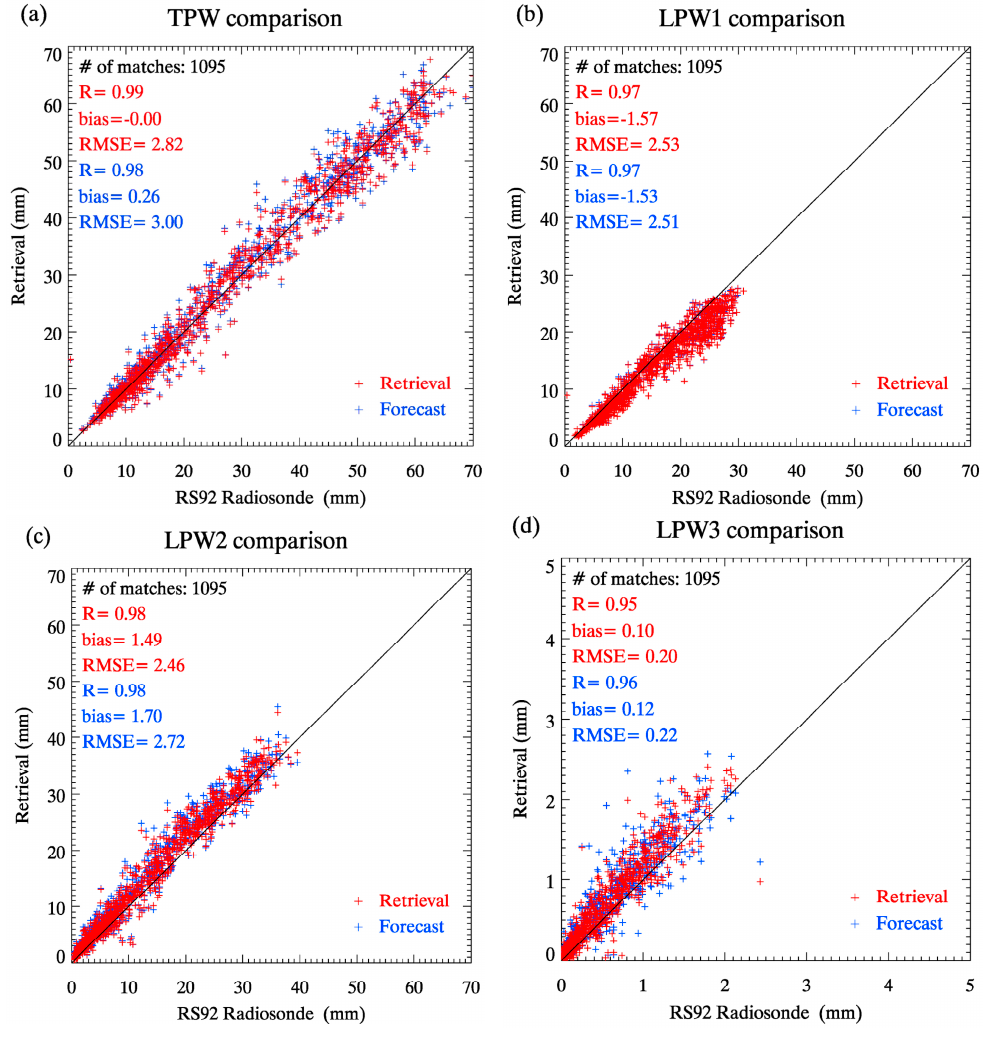
Figure 13 Figure 13. Comparison result of the retrieved ( a ) TPW ( b ) LPW1 ( c ) LPW2 ( d ) LPW3 with RAOB (RS92) for one month, August